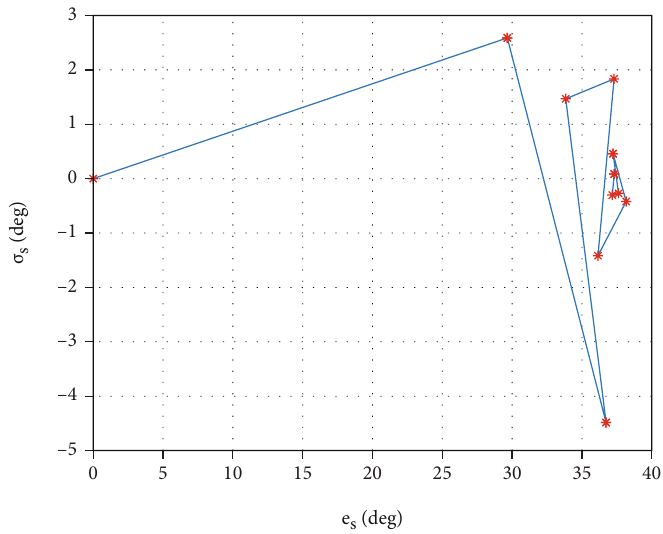
Figure 8: Simplex optimal vertex iterative change diagram with a range of 6000 km.